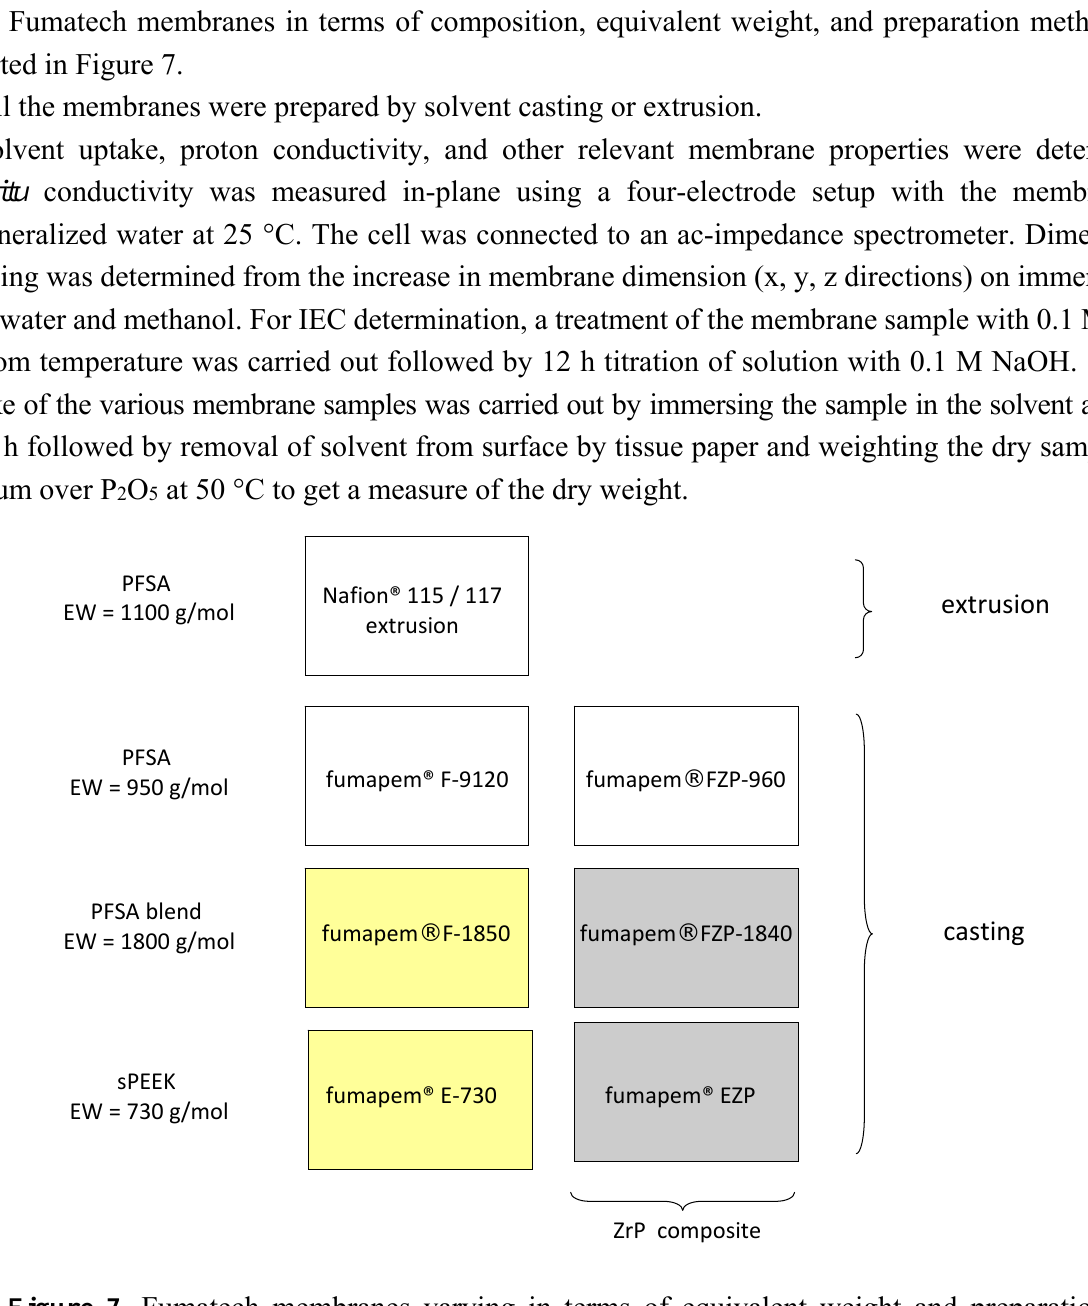
Figure 7. Fumatech membranes varying in terms of equivalent weight and preparation procedures for DMFC